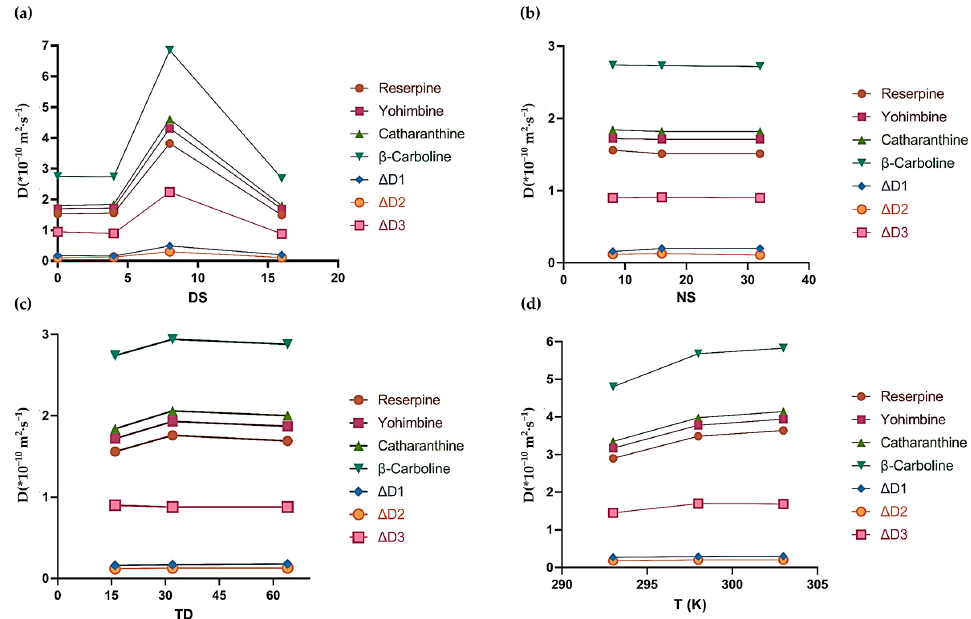
Figure 5. ( a ) The influence of a DS on the diffusion coefficient and resolution. The DS was set as 0, 4, 8, and 16. ( b ) The influence of NS on the diffusion coefficient and resolution. NS was set as 8, 16, and 32. ( c ) The influence of TD on the diffusion coefficient and resolution. TD was set as 16, 32, and 64. ( d ) The influence of experimental temperature (T) on the diffusion coefficient and resolution. T was set as 293 K, 298 K, and 303 K. Each component was 2 mg. DMSO- d 6 was chosen as the solvent.